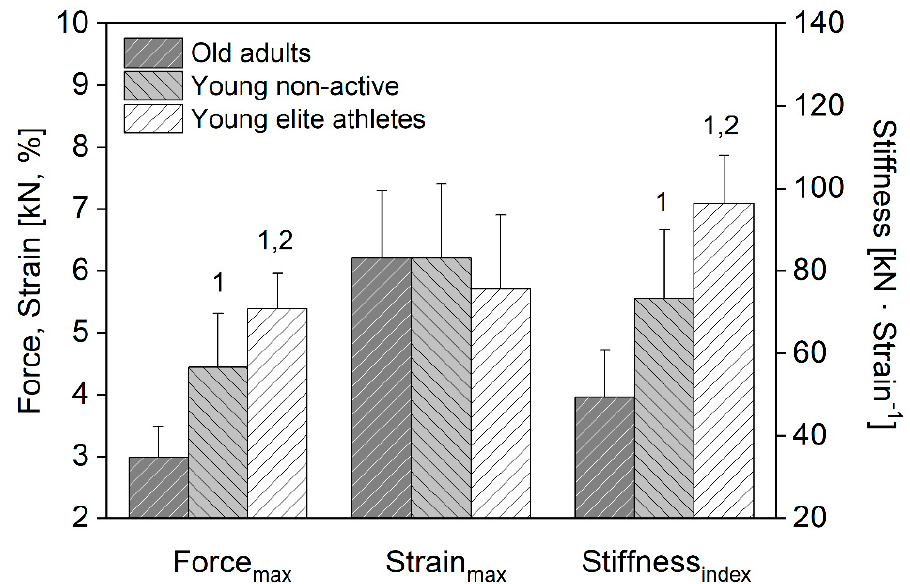
Figure 3. Means and SD of Achilles tendon maximal force, maximal strain, and stiffness index for the older adults ( n = 8), younger non-active subjects ( n = 11), and elite athletes ( n = 8). 1 Statistically significant differences compared to the older subject group ( p < 0.05). 2 Statistically significant differences compared to the younger non-active subject group ( p <